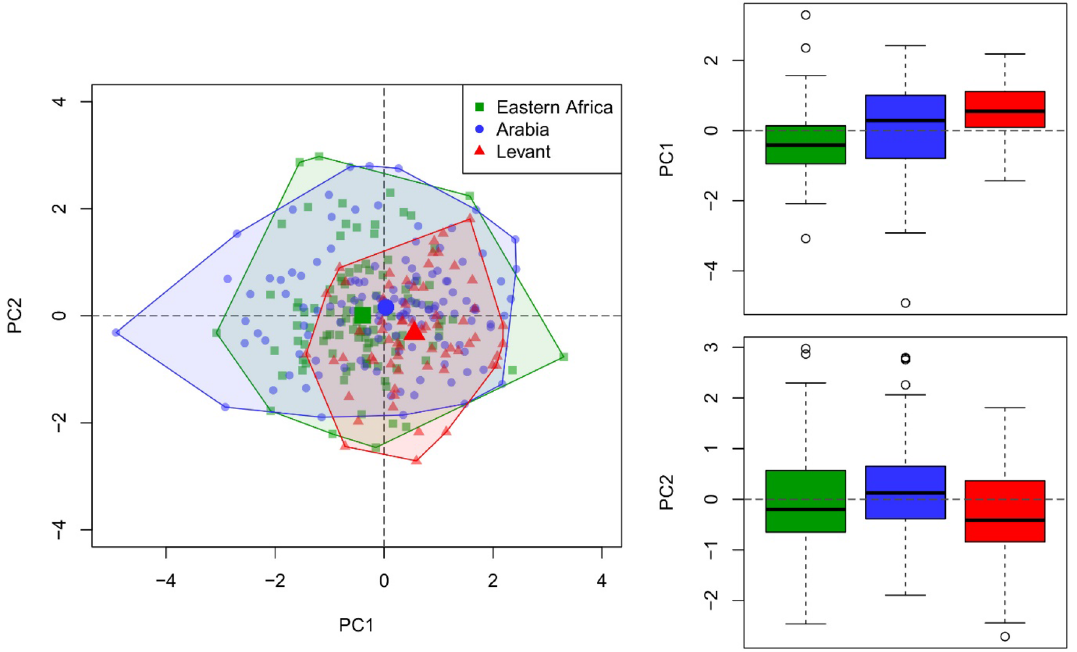
Figure 3. Biplot (left) and boxplots (right) of first two principal components identified in analysis of core shape which account for 61% of identified variability and differ significantly between